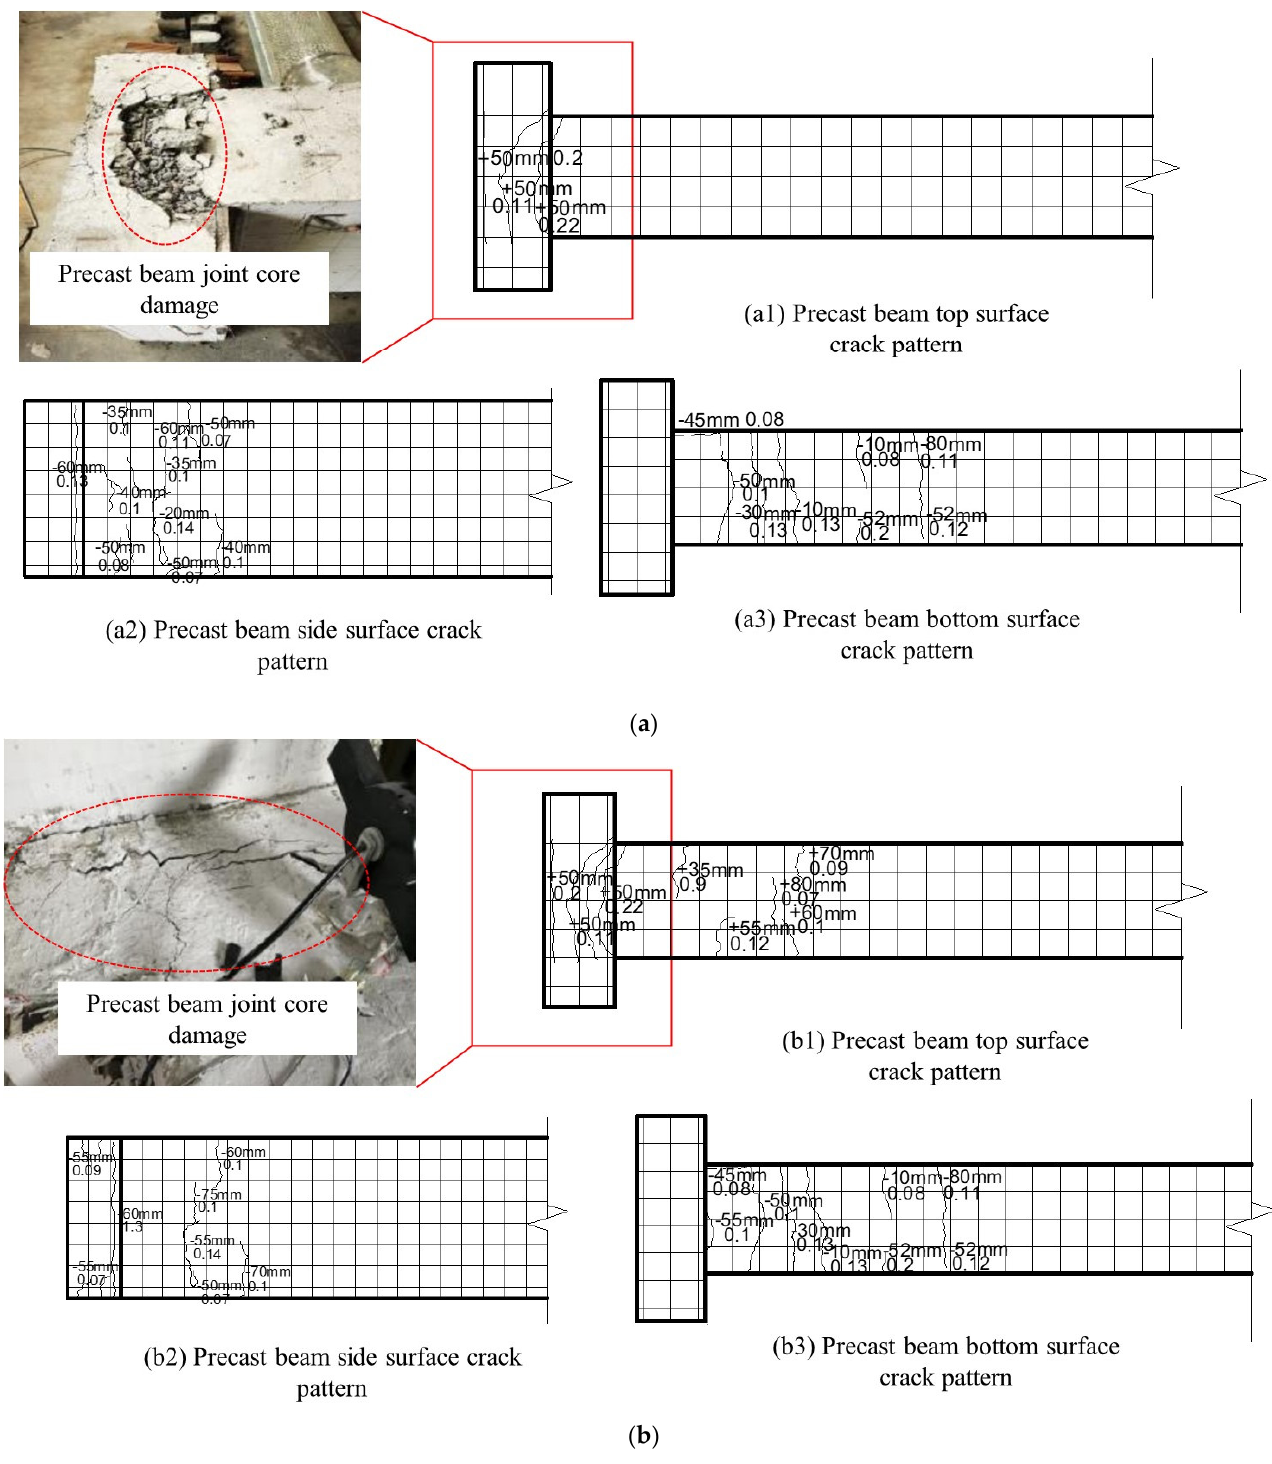
Figure 14. Diagram of experimental phenomena. ( a ) J1 crack distribution; ( b ) J2 crack